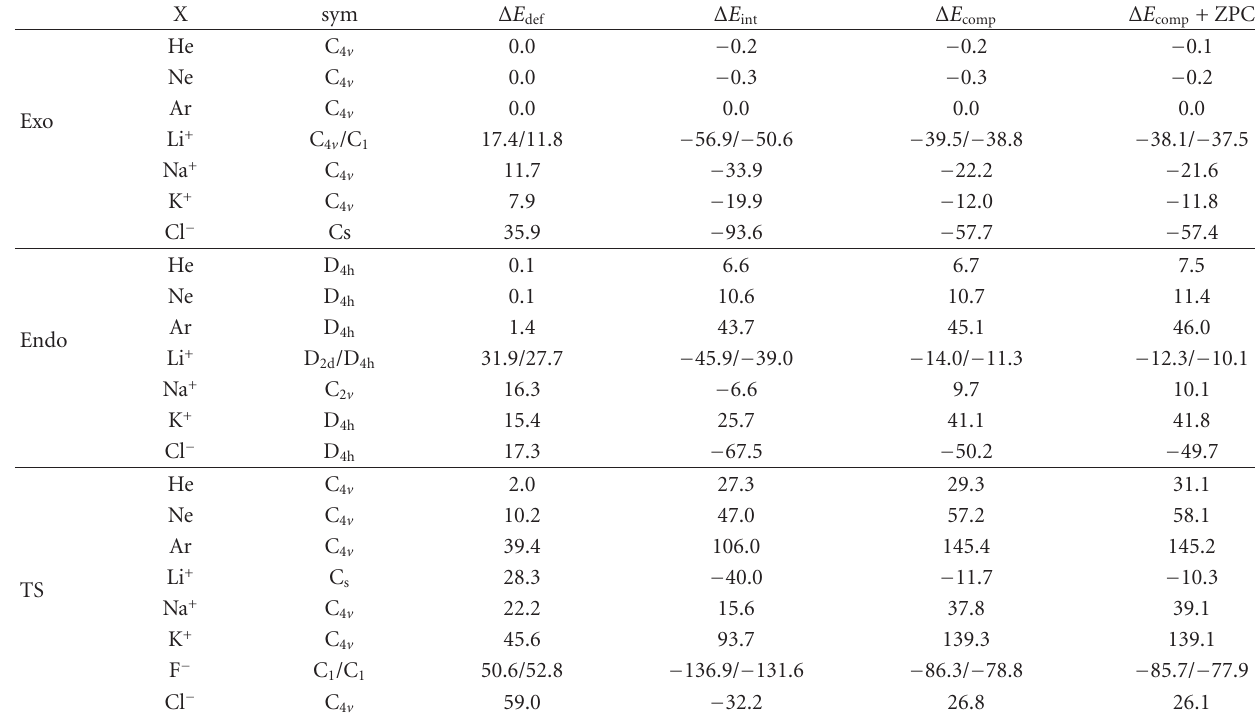
Table 5: Energy decomposition of the binding energy ( Δ E comp ) (kcal/mol) of the complexes of various guest species and Ti-T8 and the transition state connecting the complexes at the B3LYP/6-311+G(d)